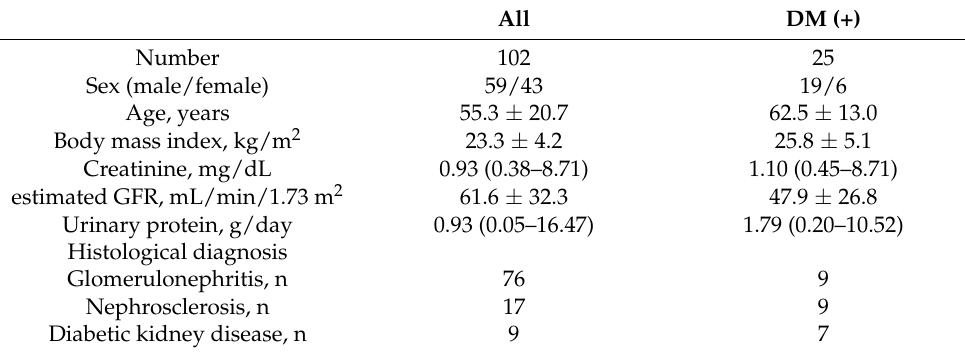
Table 1. Patients’ characteristics.